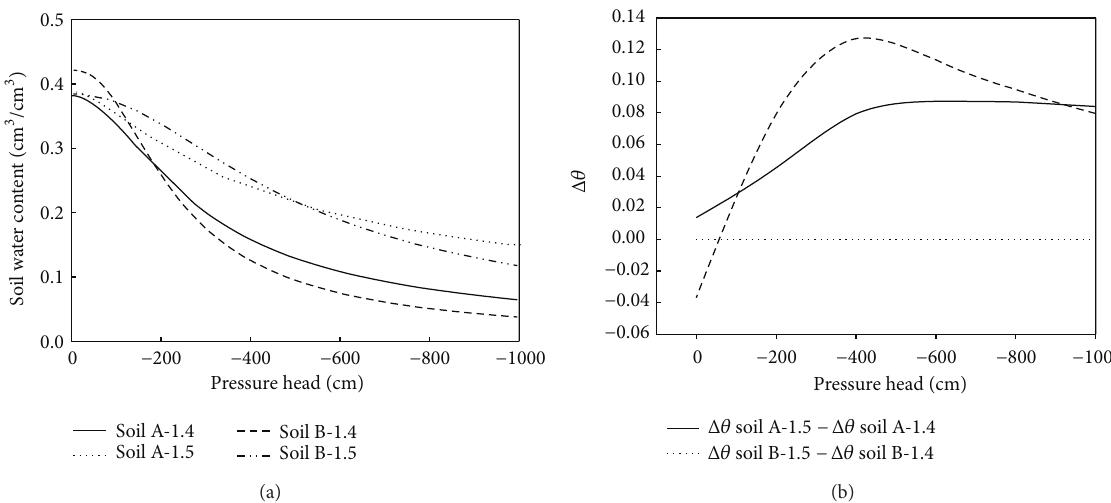
Figure8:(a)Simulatedsoilwaterretentioncurvesfortwosoilscolumnspackedatdifferentbulkdensities(1.4or1.5 g/cm 3 );(b)thedifferences in soil water content ( Δ𝜃 ) at the same pressure